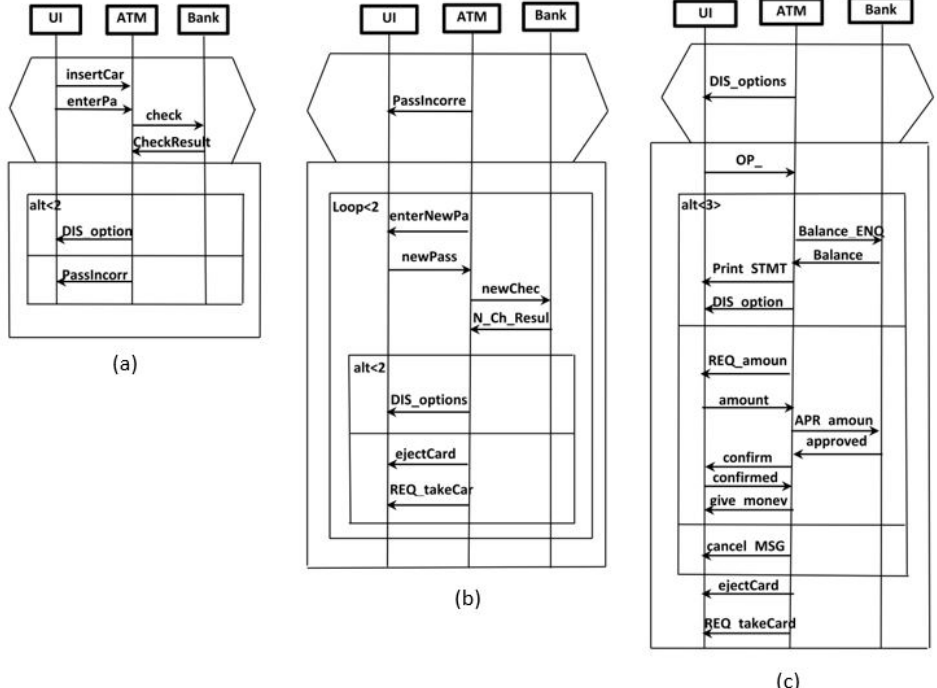
Figure A1. System specifications of ATM case study in form of s-TS . ( a ) Scenario of card inser- tion (scenario 1). ( b ) Scenario of incorrect password (scenario 2). ( c ) Scenario of display options (scenario